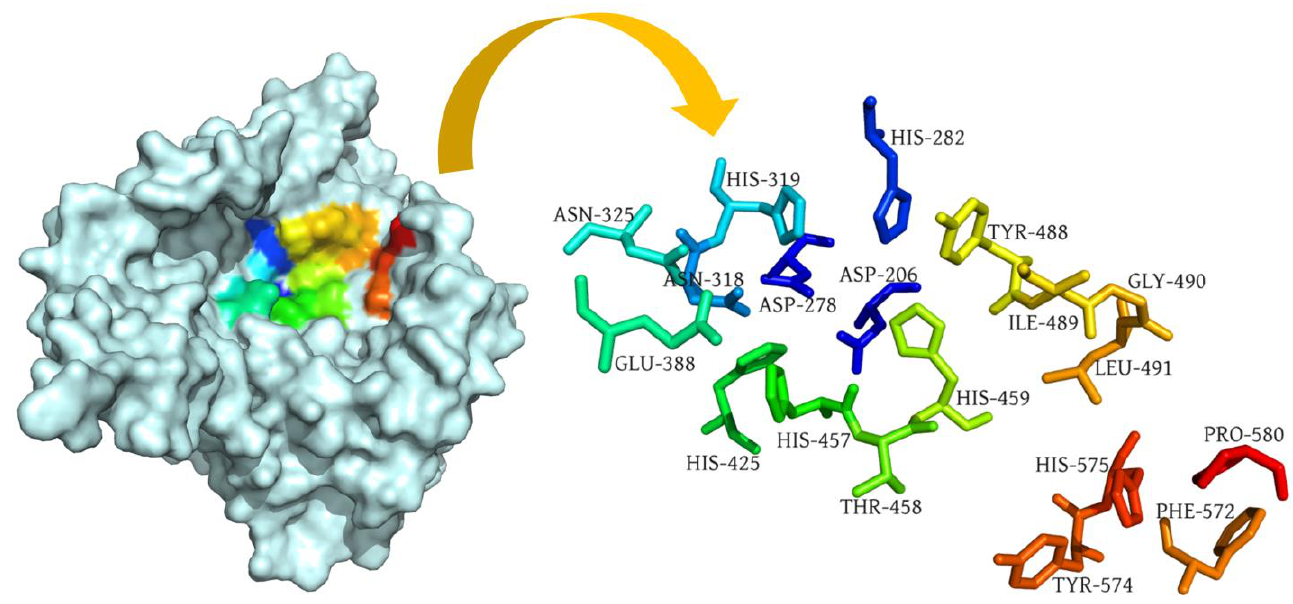
Figure 3. Surface representation of human acid sphingomyelinase (PDB: 5I81) with labelled binding pocket residues demonstrated in rainbow colors.